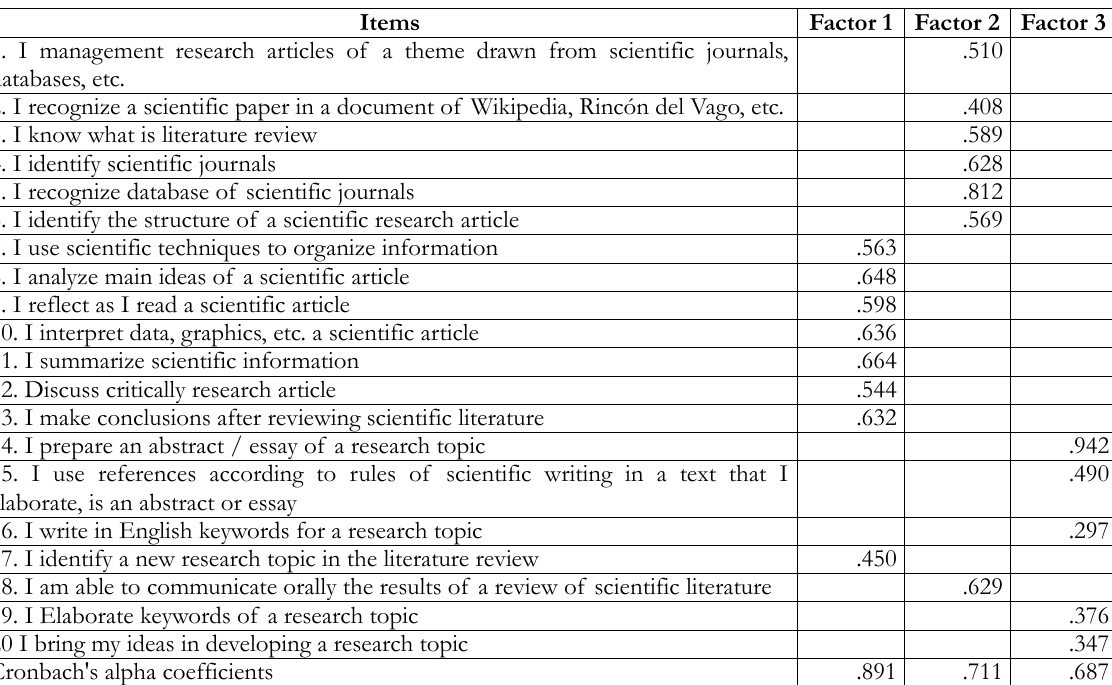
Table 2. Matrix rotated component and Cronbach´s Alpha by